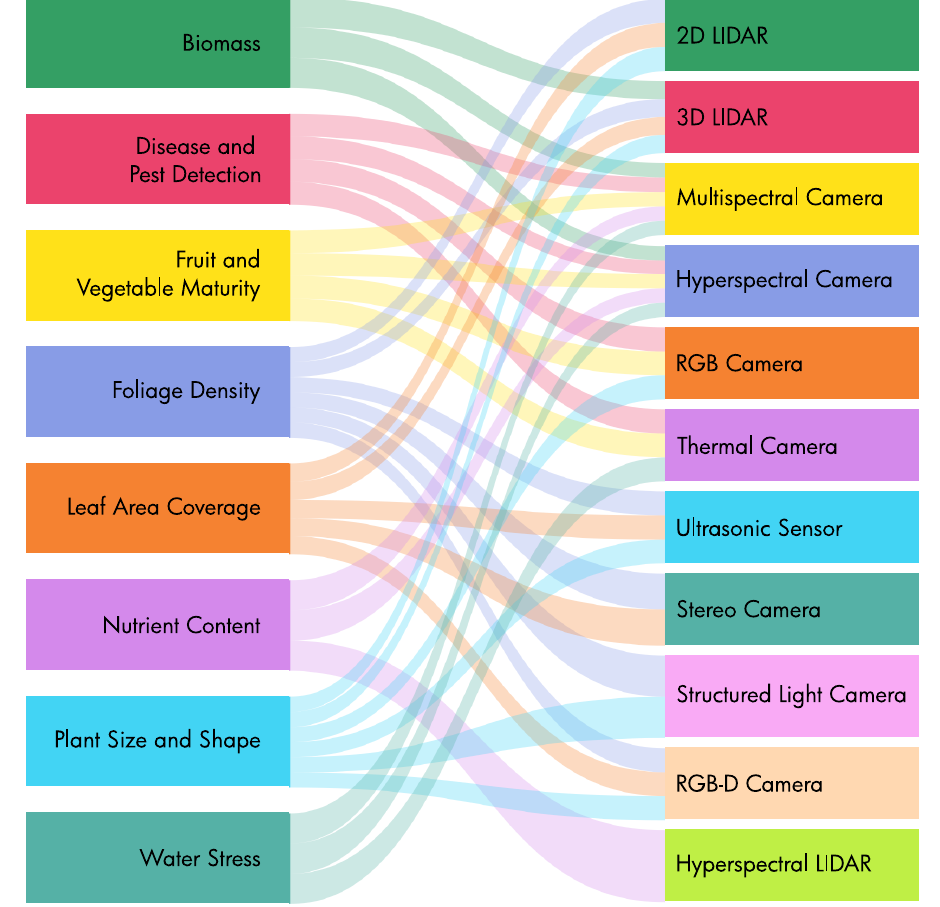
Figure 2. Remote sensing phenotype features and their corresponding